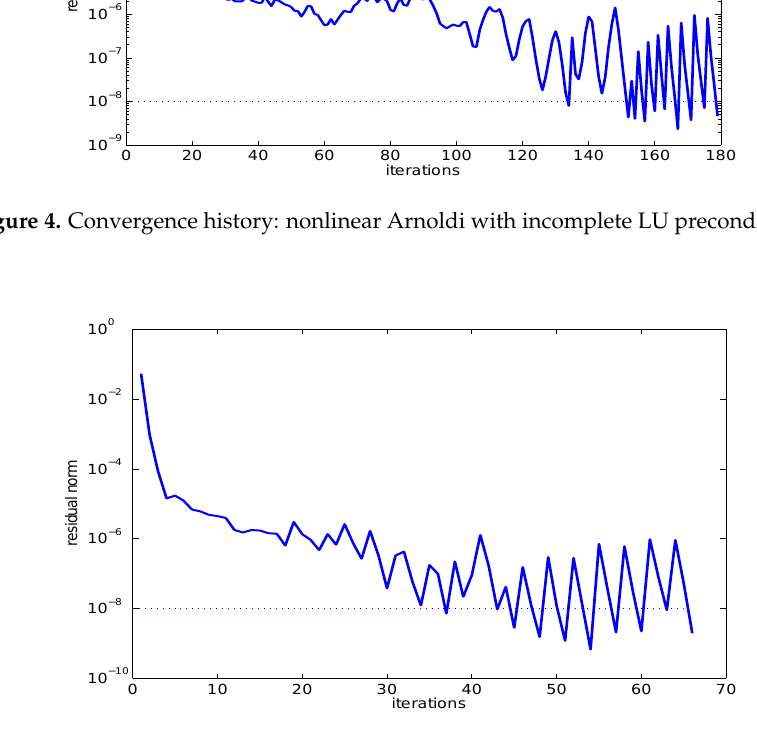
Figure 5. Convergence history: Jacobi–Davidson with incomplete LU